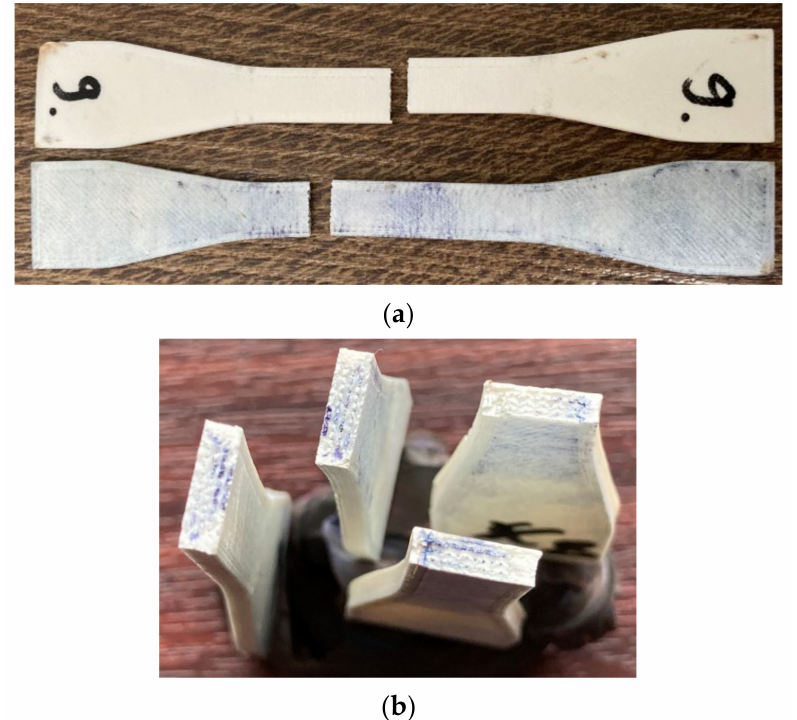
Figure 7. Disinfectant infiltration within tensile specimens: ( a ) infiltrated specimen vs. control specimen; ( b ) disinfectant infiltrations in 3D-printed specimens.